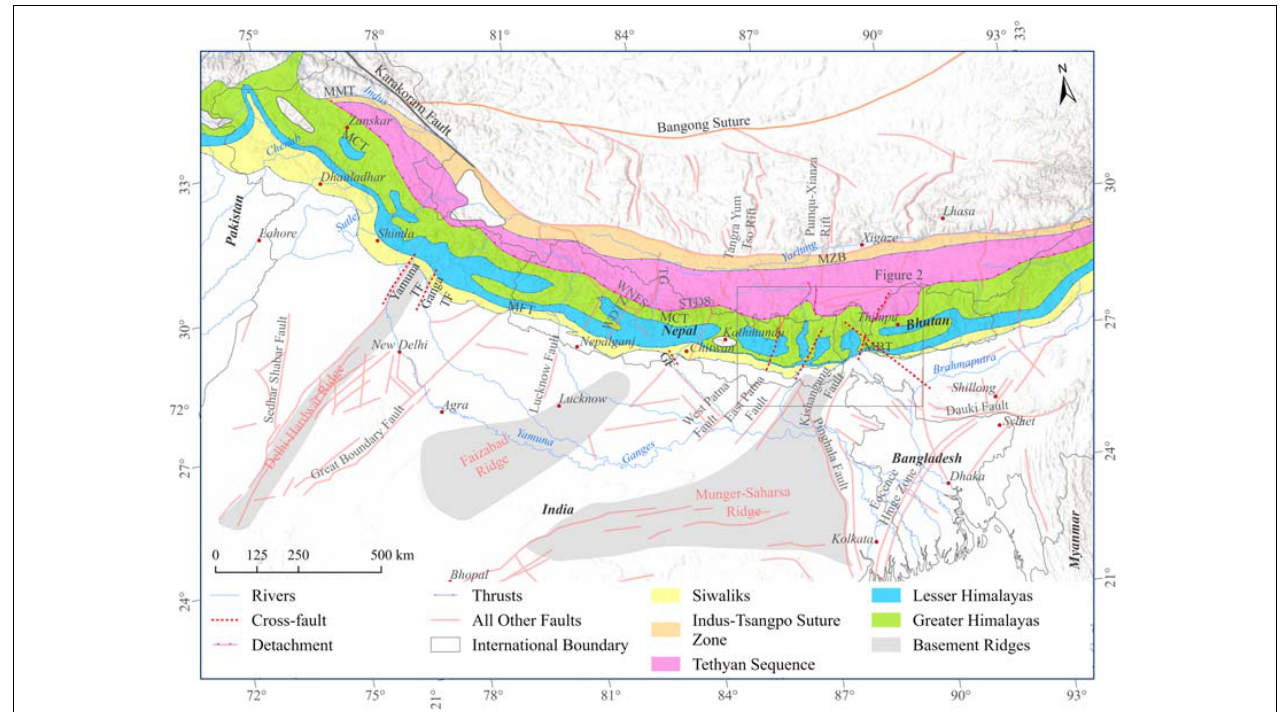
FIGURE 1 | Simplified lithotectonic map of the Himalaya. The heavy, dashed red lines indicate Himalayan cross structures. The brick-colored lines represent extensional structures on the Tibetan Plateau and basement faults on the Indian craton. The light gray shaded areas are basement ridges. GF: Gardi Tear Fault; MBT: Main Boundary Thrust; MCT: Main Central Thrust; MFT: Main Frontal Thrust; STDS: South Tibetan Detachment System; TF: Tear Fault; TG: Thakkhola graben; WNFS: Western Nepal Fault System (source: the Department of Mines and Geology, Nepal; Gansser, 1964; Godin and Harris, 2014; Diehl et al., 2017; Divyadarshini and Singh, 2019; the Geological Survey of India; Sastri et al., 1971; Sahoo et al., 2000; Searle et al., 2003; Jessup et al., 2008; Silver et al., 2015; Seifert, 2019 and compiled by Bibek